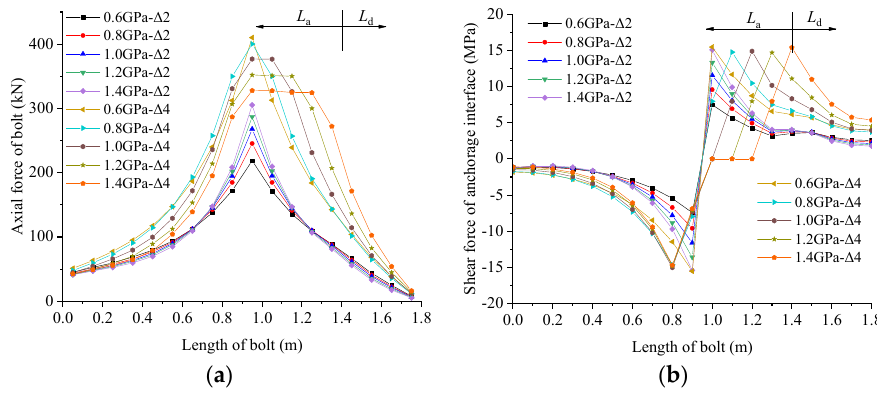
Figure 12. Simulation results of the different bond stiffness. ( a ) Axial force of the bolt. ( b ) Shear force of the anchorage interface.